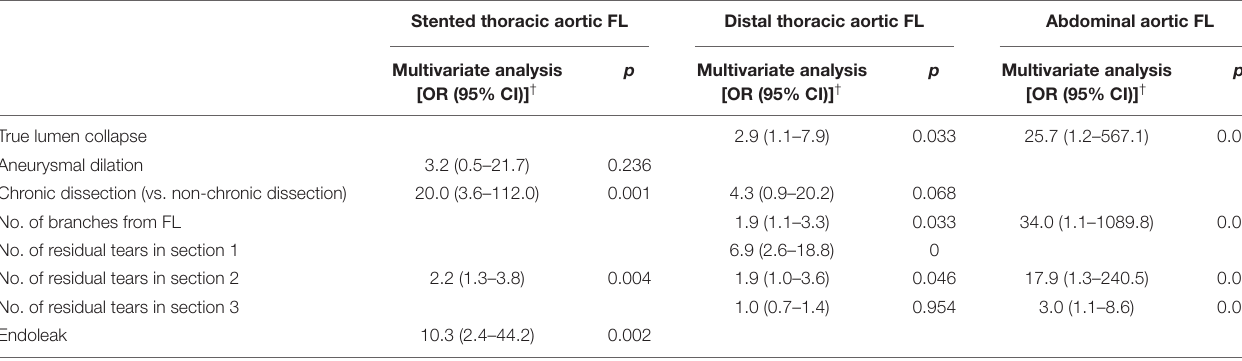
TABLE 4 | Analysis of risk factors influencing aortic remodeling of false lumen. Stented thoracic aortic FL Distal thoracic aortic FL Abdominal aortic